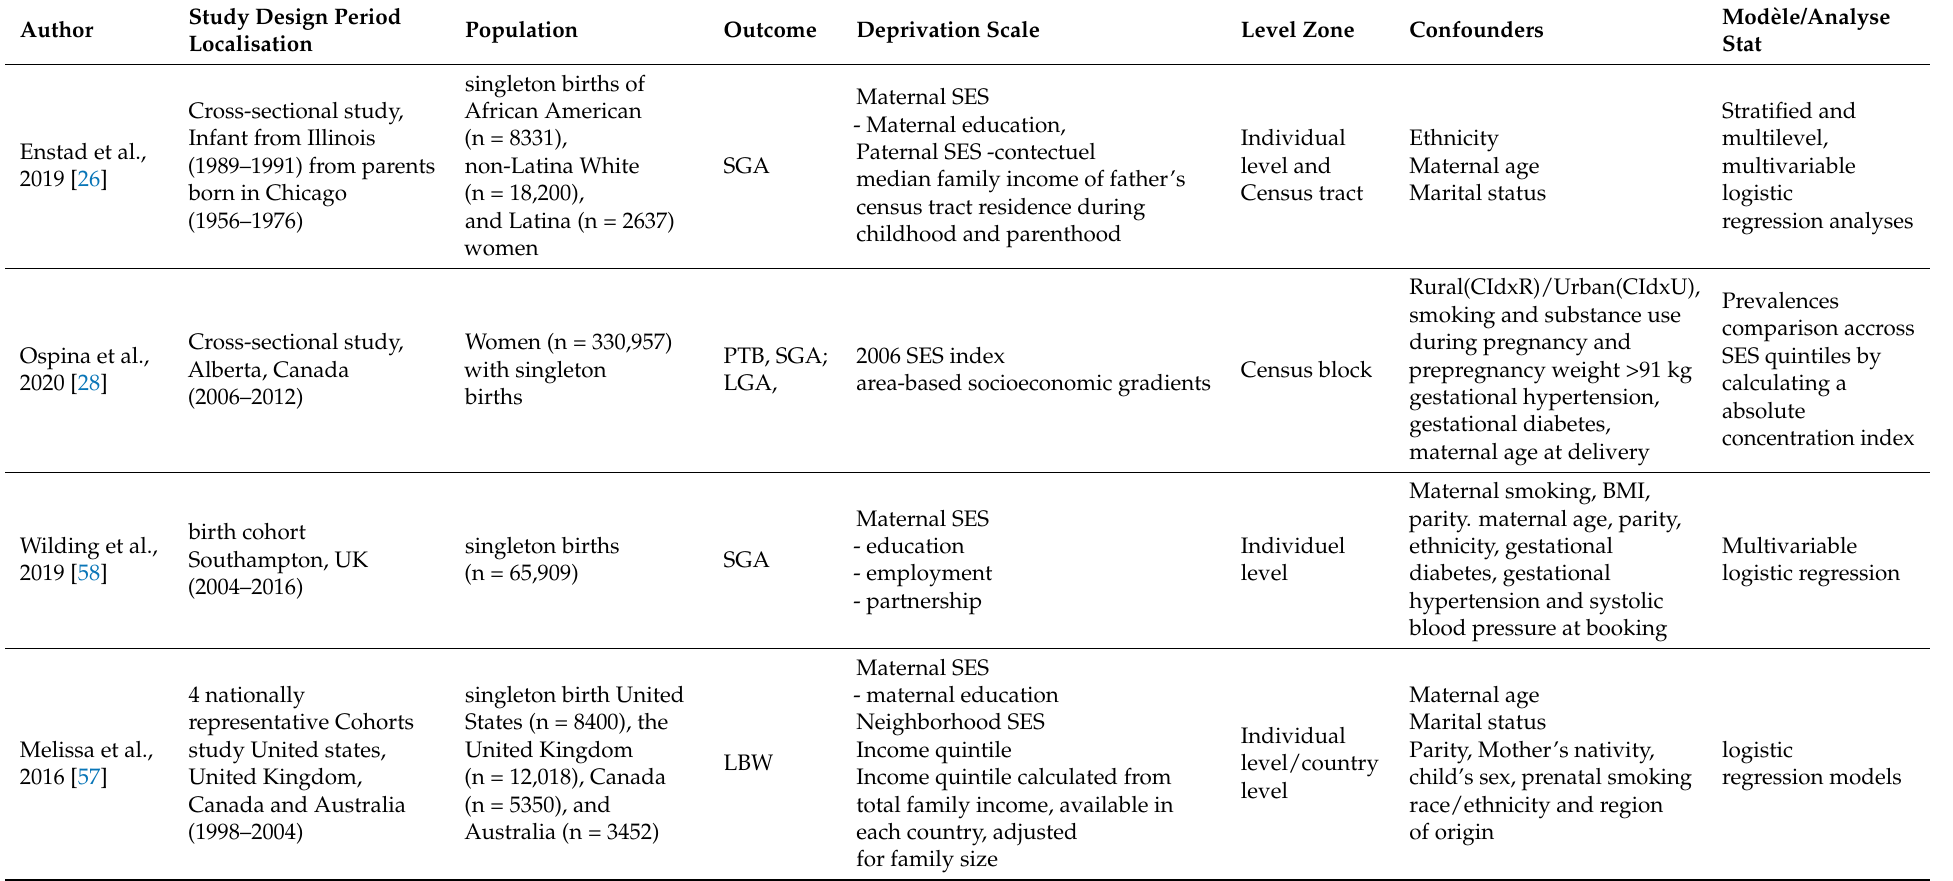
Table 1. Main characteristics of the selected